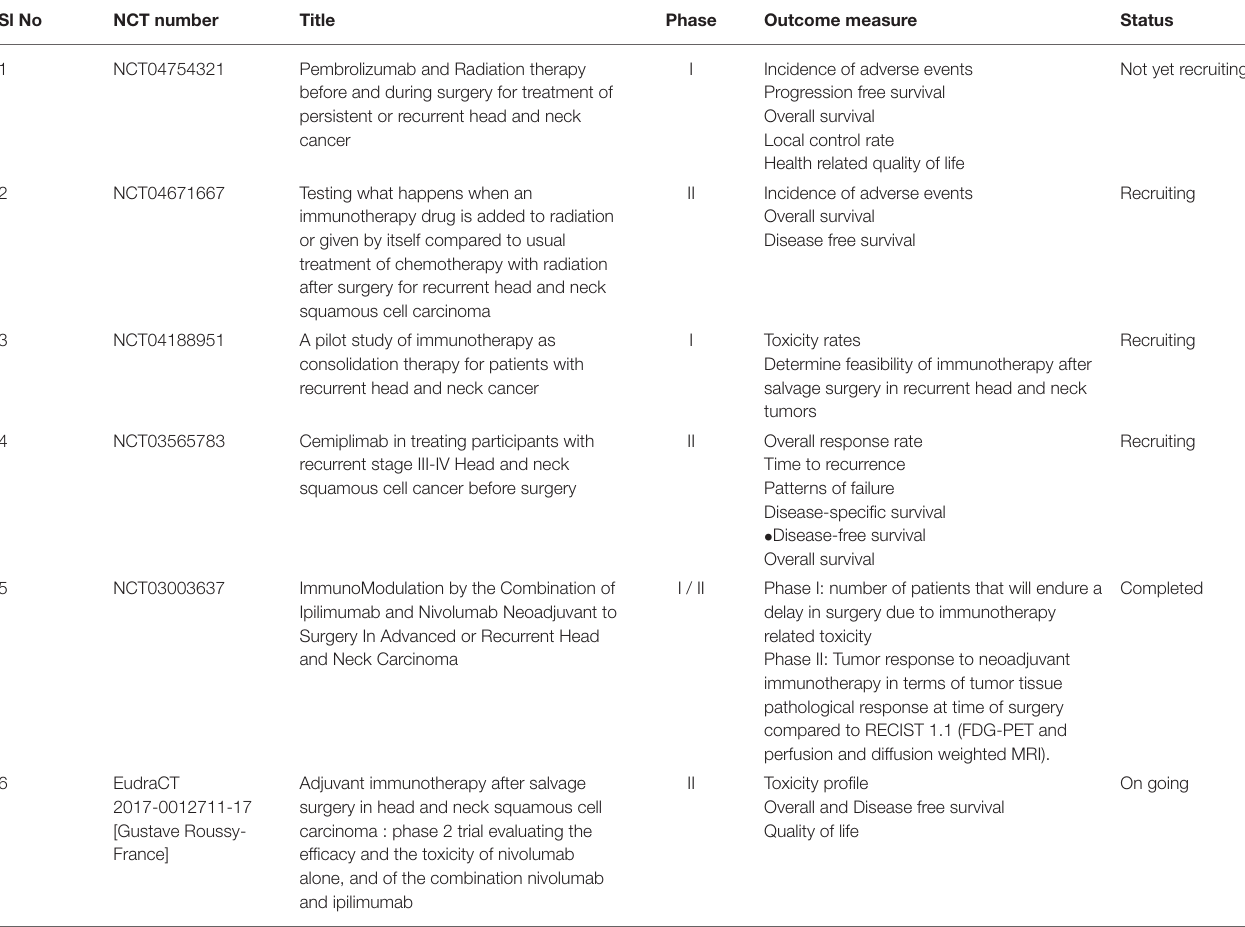
TABLE 2 | Illustrative listing of clinical trials examining impact of combining immunotherapy in salvage surgery setting in recurrent head and neck cancers. Sl